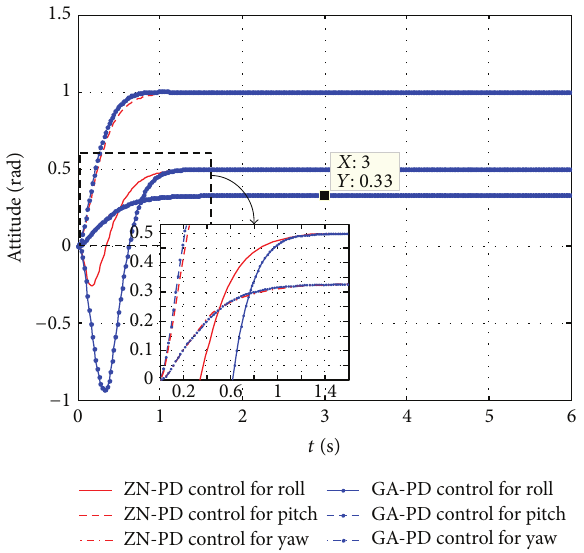
Figure 9: The control effects compare diagram between ZN-PD and GA-PD of jointly controlling three attitude angles to the expectations.